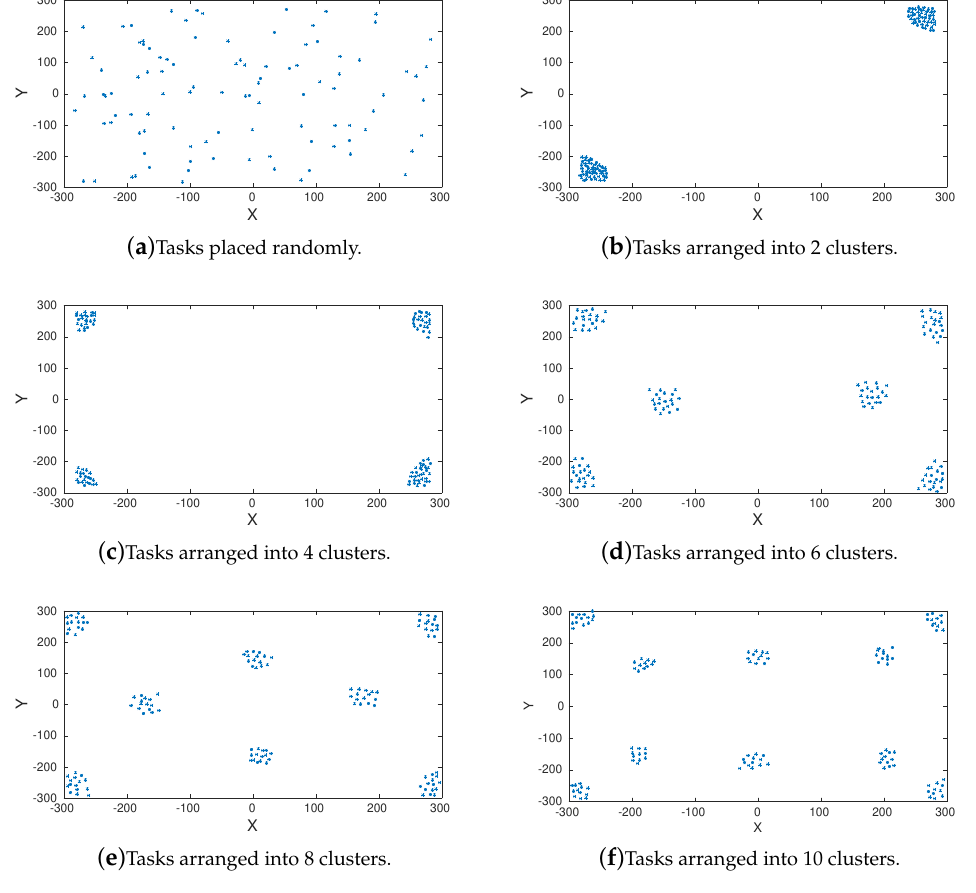
Figure 1. Environments with 120 tasks used for the experiments. Blue dots represent the position of the tasks or